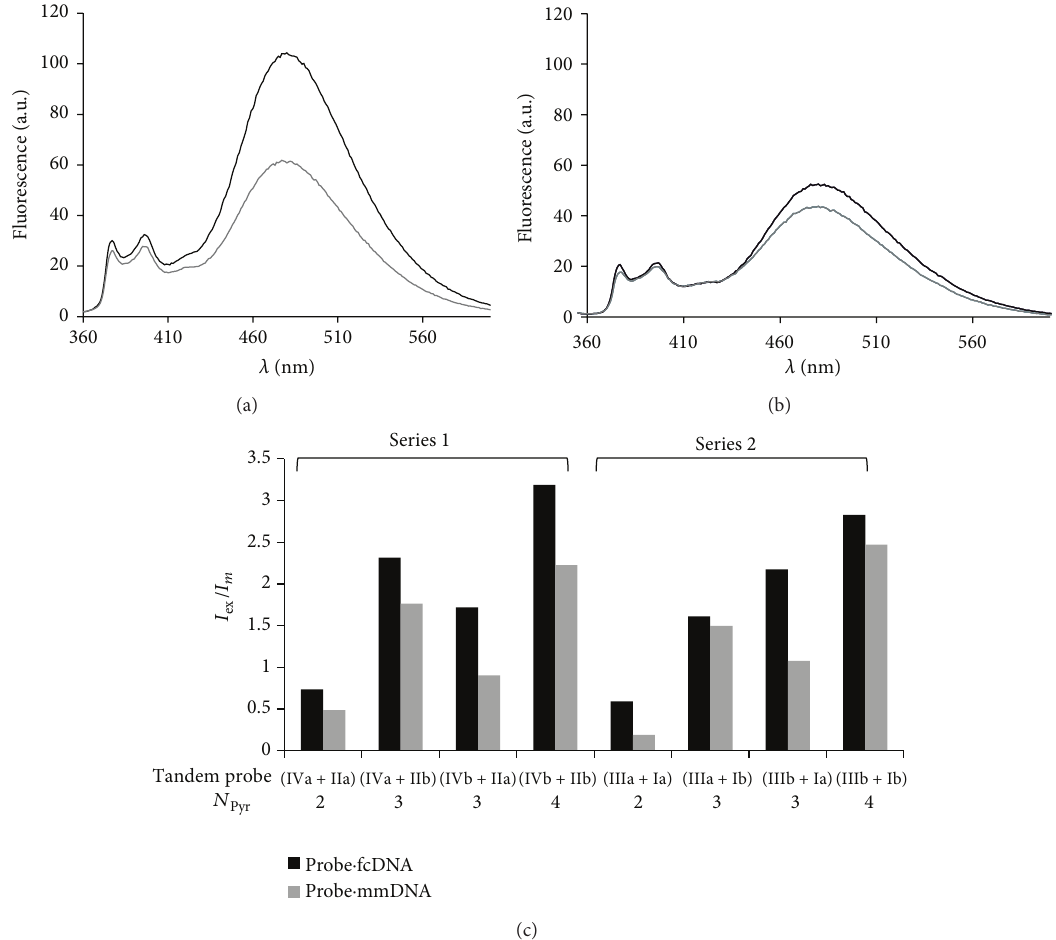
Figure 4: Fluorescent spectra of mismatched (probe ⋅ mmDNA) (gray) and fully complementary (probe ⋅ fcDNA) (black) duplexes of tandem /𝐼 probes IVb+IIb (A) and IIIb+Ib (B); C) 𝐼 𝑚 values for the mismatched (gray) and fully complementary (black) duplexes of tandem probes ex (Series 1 and Series 2). See conditions of fluorescent spectra recording under Figure 3 and in Section